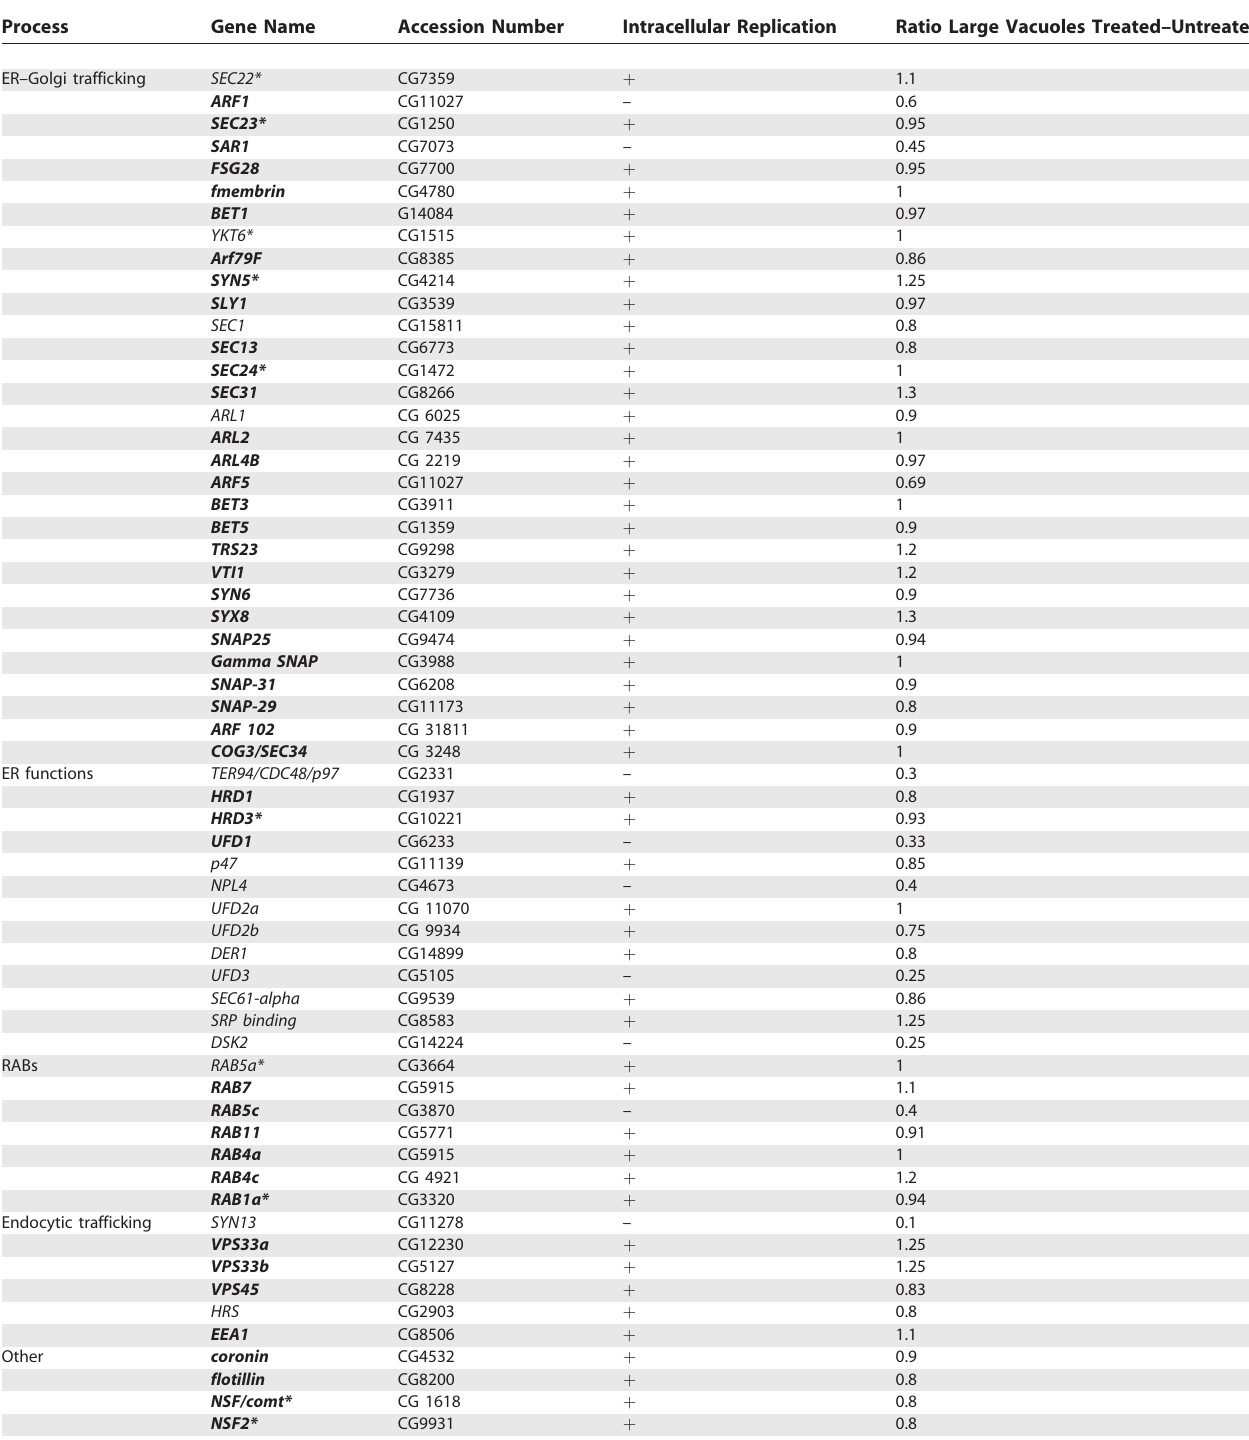
Table 1. dsRNA Treatments Tested for Their Effect on L. pneumophila